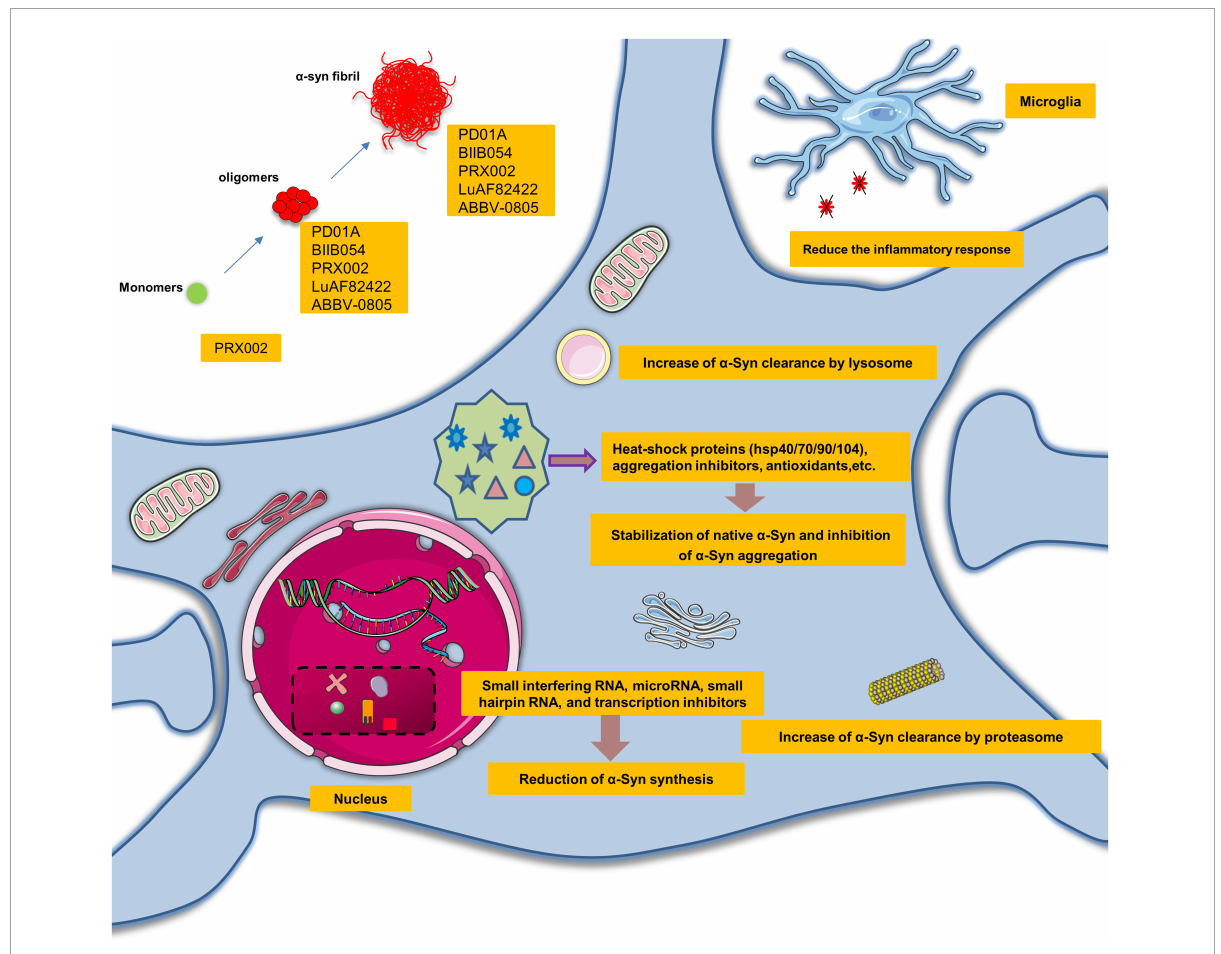
FIGURE4 Promising therapeutic perspectives and clinical trials targeting α -synuclein seeding. α -Syn-directed therapeutics might require alleviating the neurotoxic gain of α -Syn seeding in several ways: reduction of α -Syn synthesis, stabilization of native α -Syn, inhibition of α -Syn aggregation, and increase of α -Syn